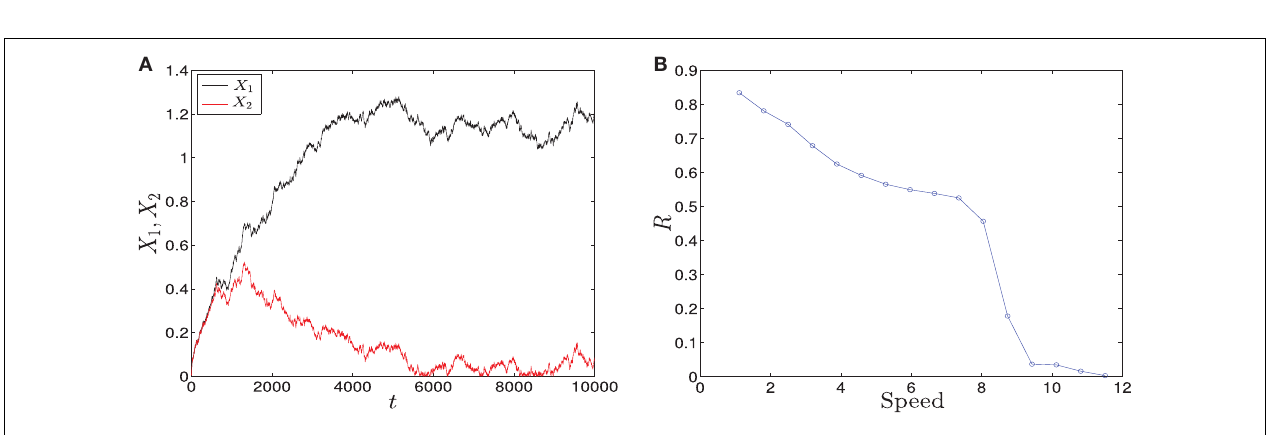
speed is increased, the ratio R changes from 1 to 0. Hence, increasing the speed causes a large switch from the favorable attractor to the other one. Parameters are a 1 = 0.2, a 2 = 0.01, k 1 = 1, k 2 = 1.1, n = 4, r = 0.5. Also, in (A) σ 2 = 0.01, (B) σ 2 =